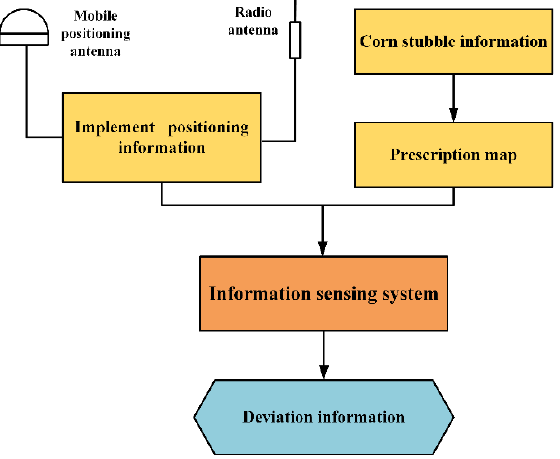
Figure 2. Flow chart of deviation-perception fusion technology.